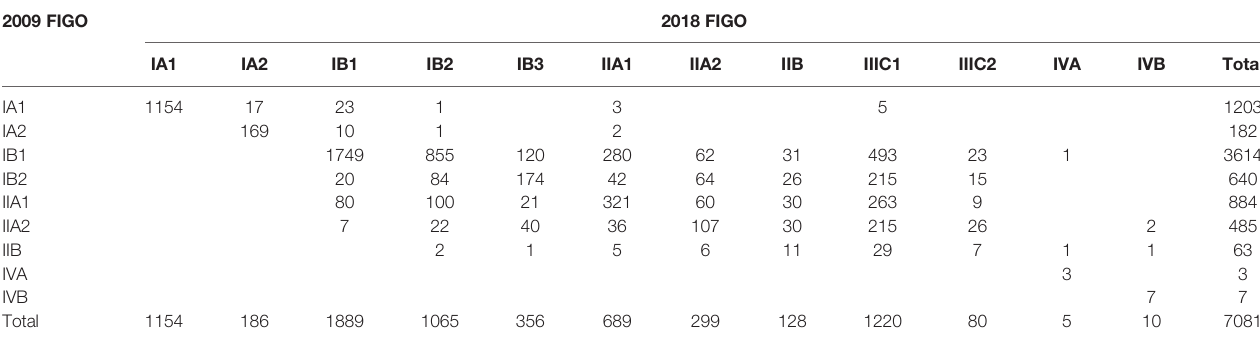
TABLE 6 | Shift in stage for cervical cancer patients from FIGO 2009 to FIGO 2018.